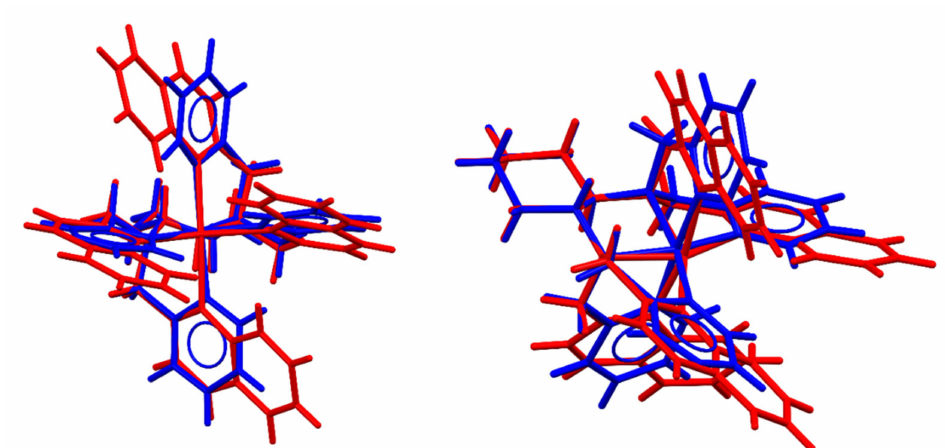
Figure 2. Overlay of structures Fe II (CDA-BQA*)](CF 3 SO 3 ) 2 ( 5 ) (red) and [Fe II (CDA-BPA*)](ClO 4 ) 2 ( 6 ) (blue) containing only ( R , R )-enantiomers of the ligands. Table 1. Selected bond lengths of complex [Fe II ( ± CDA-BQA*)](CF 3 SO 3 ) 2 ( 5 ) compared to the literature example